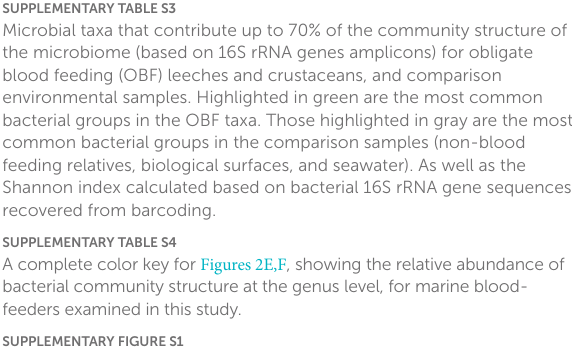
SUPPLEMENTARY TABLE S1 Specimens analyzed in this study, showing specimen ID, collection year, location, and host vertebrate, listed in the same order as in the stacked bar charts in Figures 2E,F . SUPPLEMENTARY TABLE S2 Results from pairwise one-way Analysis of Similarities (ANOSIM) analysis for all comparisons mentioned in the text. SUPPLEMENTARY TABLE S3 Microbial taxa that contribute up to 70% of the community structure of the microbiome (based on 16S rRNA genes amplicons) for obligate blood feeding (OBF) leeches and crustaceans, and comparison environmental samples. Highlighted in green are the most common bacterial groups in the OBF taxa. Those highlighted in gray are the most common bacterial groups in the comparison samples (non-blood feeding relatives, biological surfaces, and seawater). As well as the Shannon index calculated based on bacterial 16S rRNA gene sequences recovered from barcoding. SUPPLEMENTARY TABLE S4 A complete color key for Figures 2E,F , showing the relative abundance of bacterial community structure at the genus level, for marine blood- feeders examined in this study. SUPPLEMENTARY FIGURE S1 Phylogenetic relationships among Vibrio associated with blood feeding marine crustaceans and leeches, relative to selected cultured representatives, based on the 16S rRNA gene. Sequences generated in this study are from clone libraries (“clone”), bacterial cultivation (“isolate”), and amplicon sequencing (“barcode”). A neighbor-joining tree with Jukes-Cantor two-parameter distances is shown. None of the nodes are supported by bootstraps, reinforcing the very close relationship among known Vibrio species, and the need for a more specific genomic taxonomy framework. Genbank accession numbers are indicated in parentheses. Vibrio barcodes shown in Figures 3 are highlighted in bold text. At right are scanning electron microscopy or blood agar hydrolysis images of bacterial isolates corresponding to the main Vibrio groups recovered from blood feeding marine crustaceans and leeches. SUPPLEMENTARY FIGURE S2 Phylogenetic relationships of bacteria associated with blood feeding marine crustaceans and leeches (based on 16S rRNA gene amplicon sequencing, designated by names beginning with ‘OBF’), compared to select close relatives recovered during other investigations. Genbank accession numbers are indicated in parentheses.